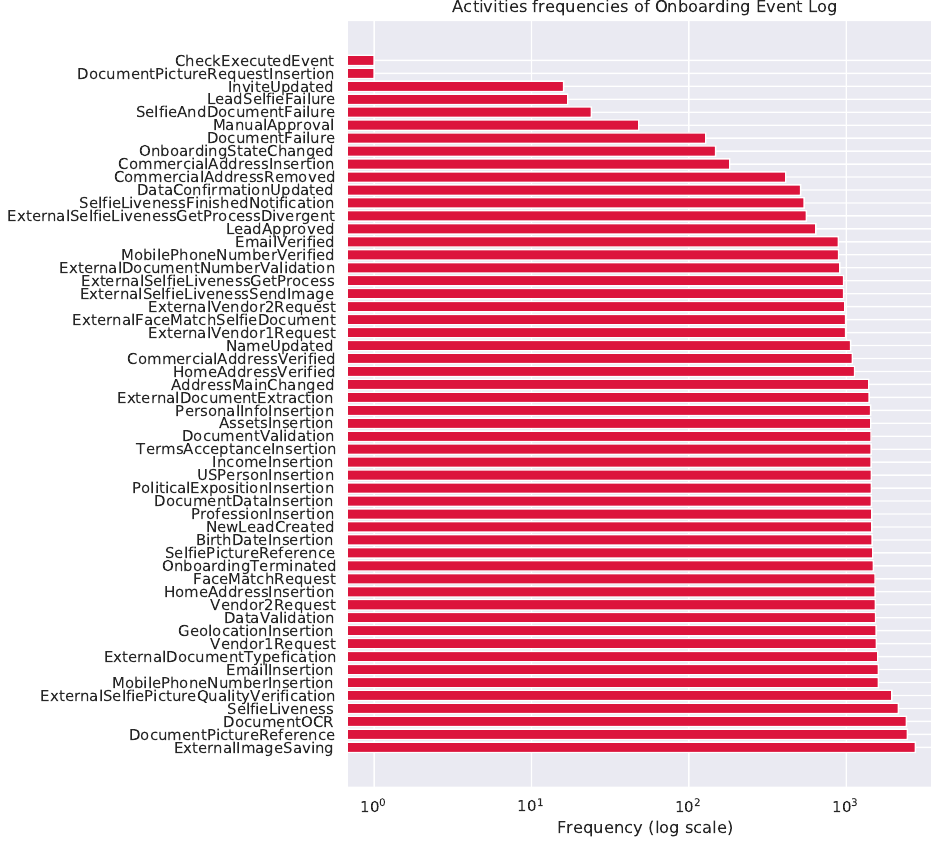
Figure 3. List of onboarding activities sorted by frequency (log scale) from lowest to